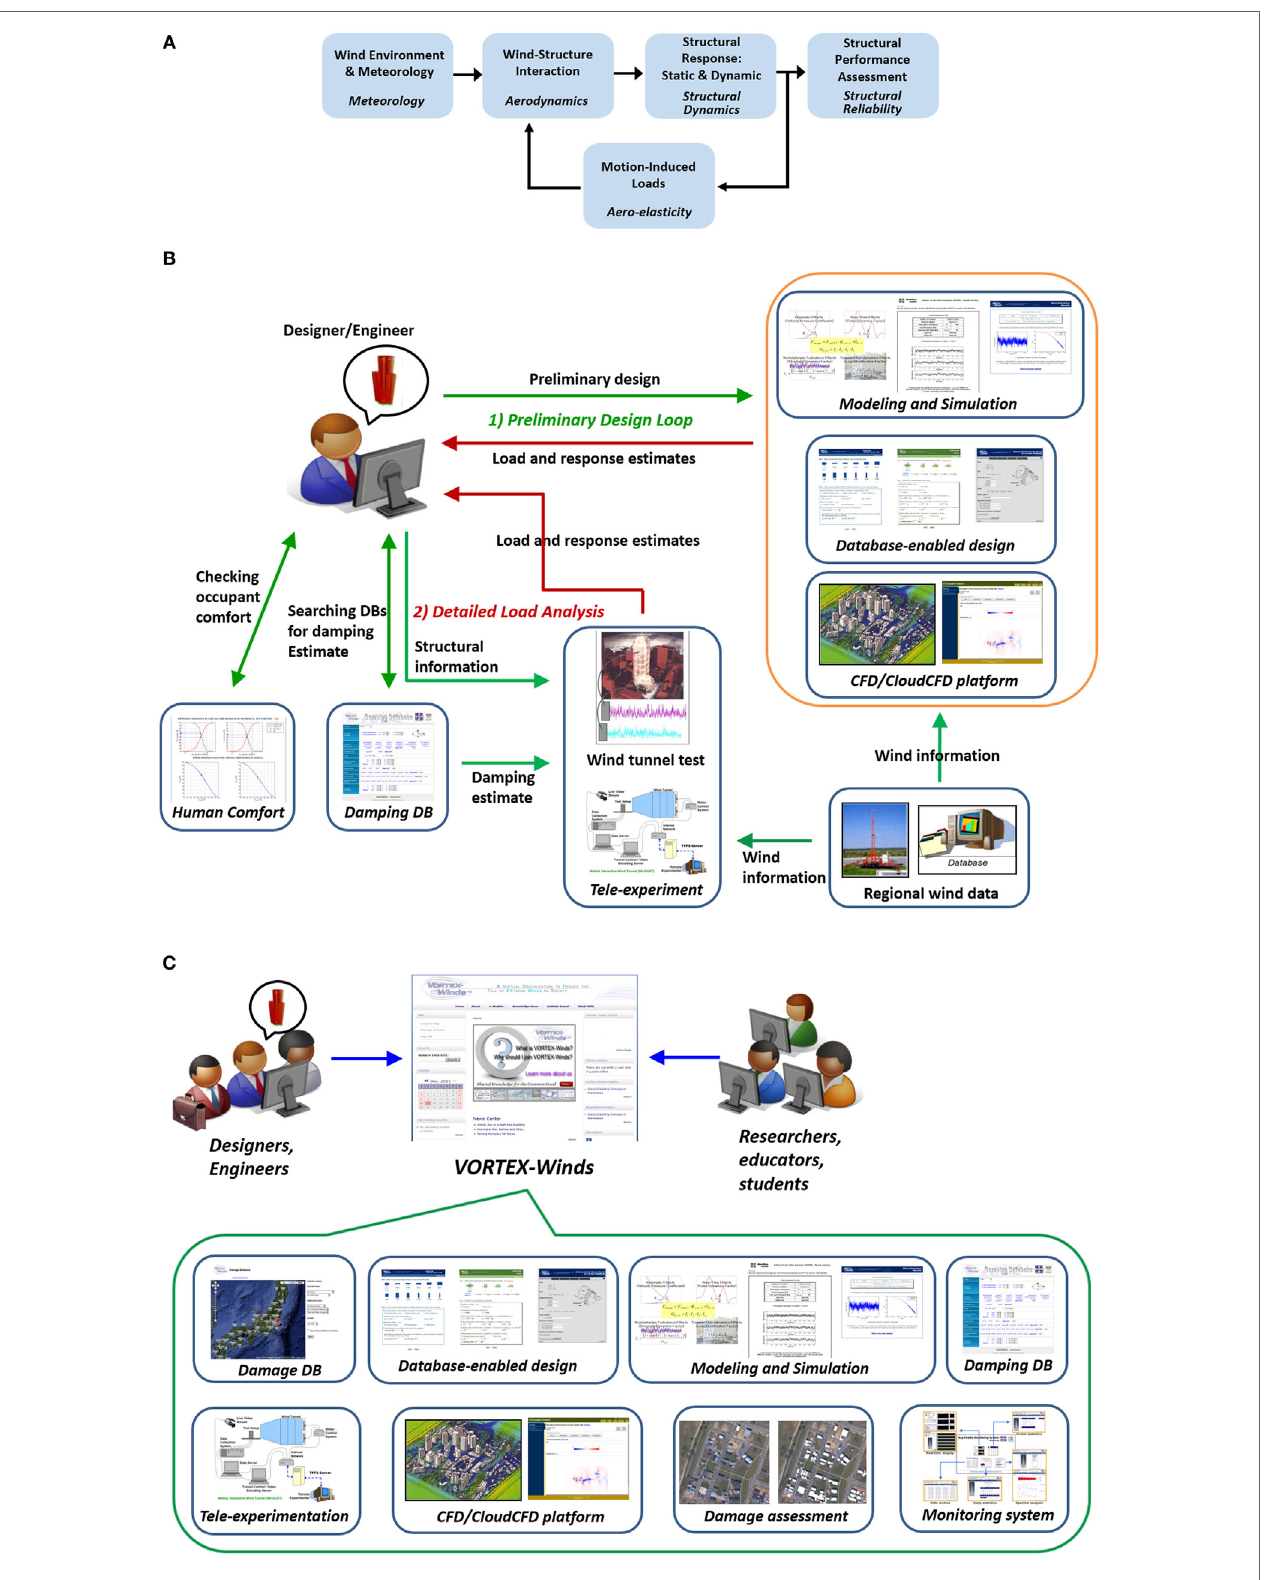
FigUre 2 | (a) Traditional off-line design. (B) Integrated analysis and design concept in VORTEX-Winds. (c) An overview of ongoing cyber-enabled modules.